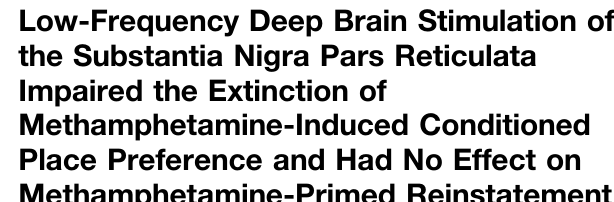
sham DBS group exhibited a dramatic increase in CPP scores compared with the HF DBS group (unpaired t test, t 14 (cid:2) 2.178, p < 0.05). Therefore, HF DBS of the SNr blocked the methamphetamine- primed reinstatement of the extinguished drug-seeking behavior.